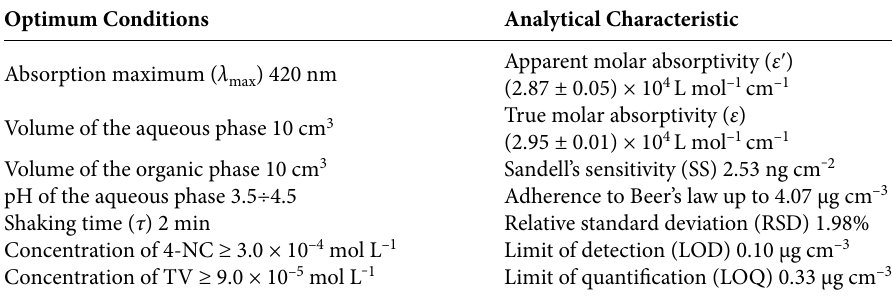
Table 1. Optimum extraction-spectrophotometric conditions and analytical characteristics of the system Ge(IV)–4-NC–TV–H